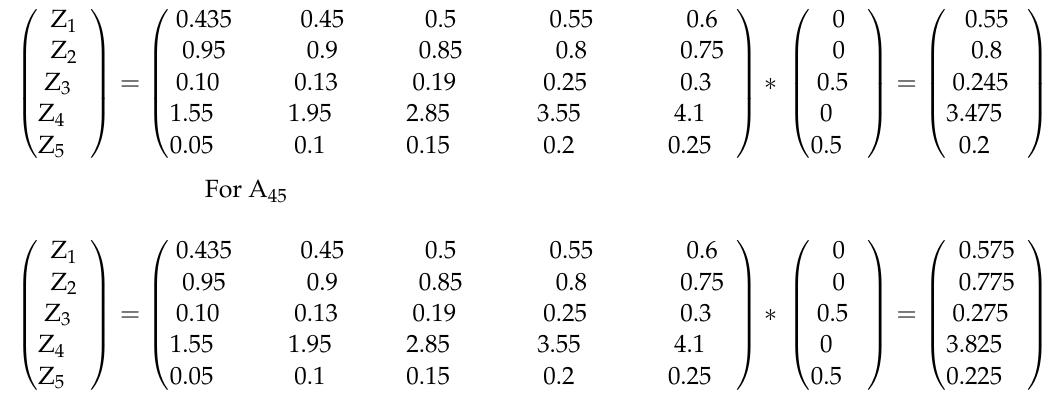
The matrix table for the mixture proportion formulation is shown in Table 1. Table 1. Mixture Proportion